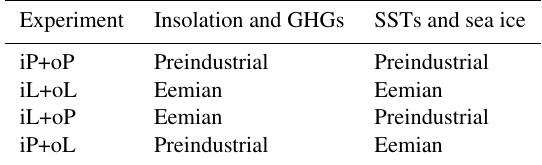
Table 1. Boundary conditions for the experiments. In the experi- ment names, the letter following “i” indicates the insolation con- ditions, while the letter following “o” indicates the oceanic condi- tions: “P” is PI (preindustrial period) and “L” is Eemian (last inter-